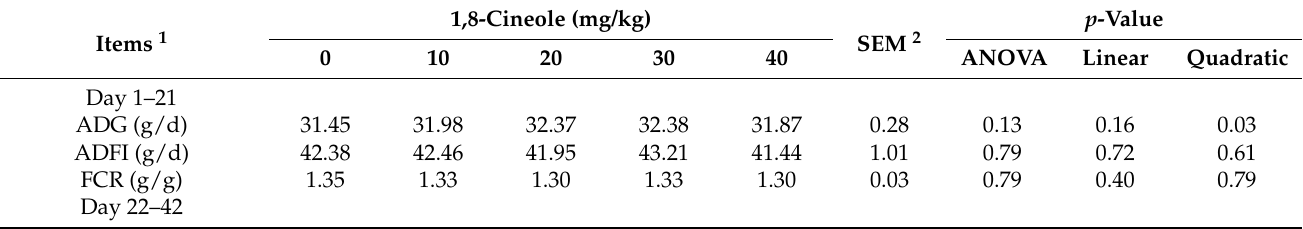
Table 2. Effects of dietary 1,8-cineole supplementation on growth performance of broiler